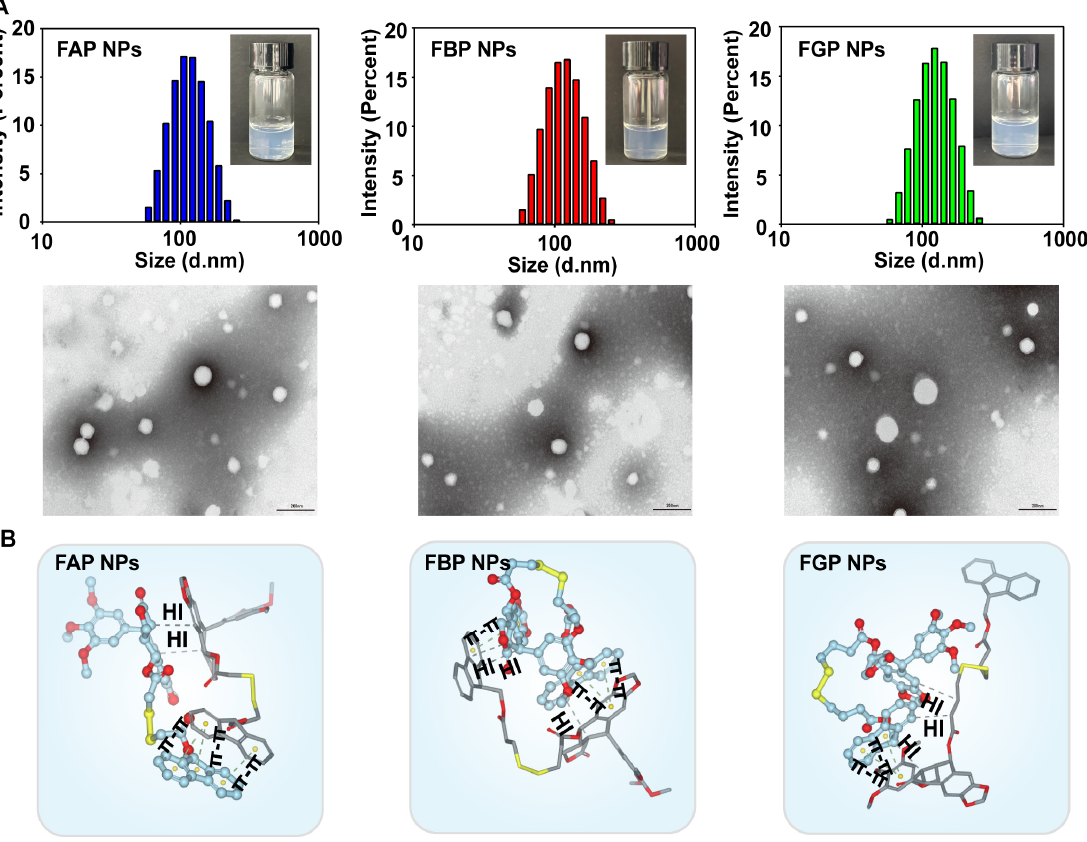
Figure 1. Preparation characterization. ( A ) Size distribution measured using the Malvern Zetasizer, TEM images and appearances of prodrug NPs. ( B ) Molecular docking simulation of prodrug NPs. π - π : π - π stacking, HI: hydrophobic interaction.